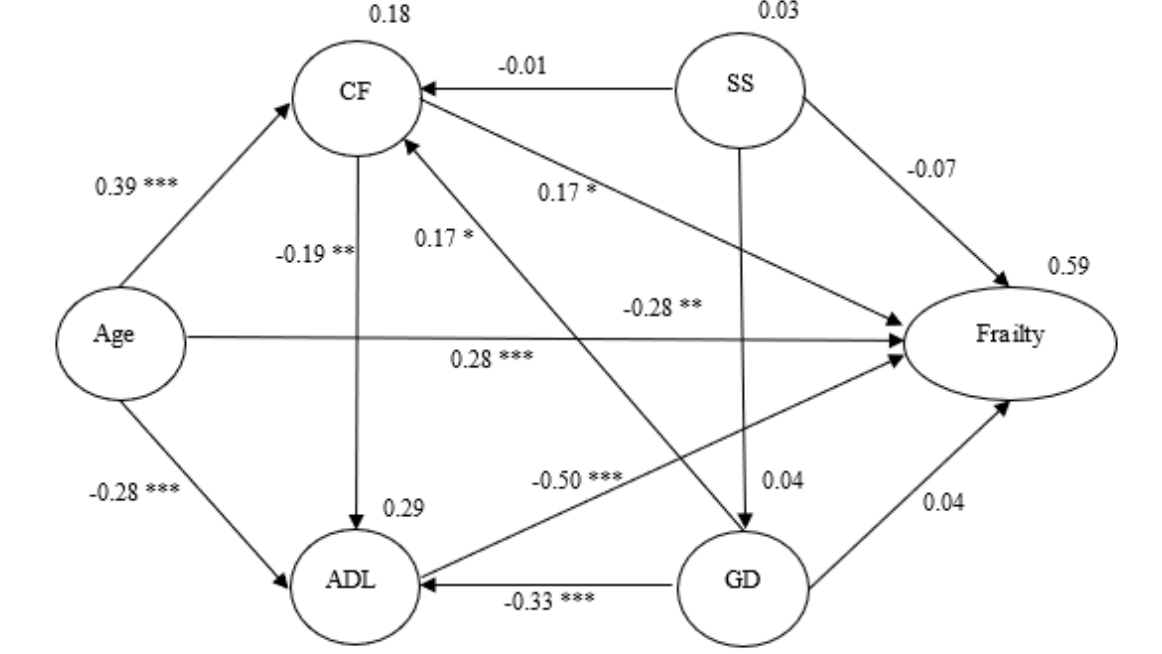
Figure 2. Hypothesized model with standardized estimates. Note. Social support- SS; Cognitive function- CF; Activities of daily living- ADL; Geriatric depression- GD; → -unidirectional path; * P < 0.05, ** P < 0.01, *** P < 0.001